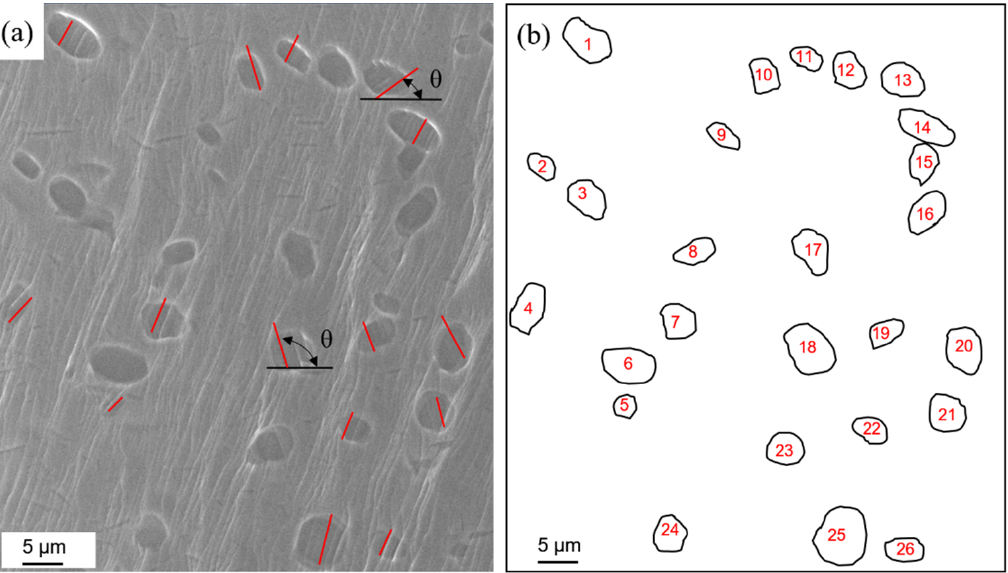
Figure 8. ( a ) Slip bands and observed θ of α 2 particles in the AOI; ( b ) schematic diagram of particle position. Table 2. The analysis of the activated slip system for #10 α 2 grain.